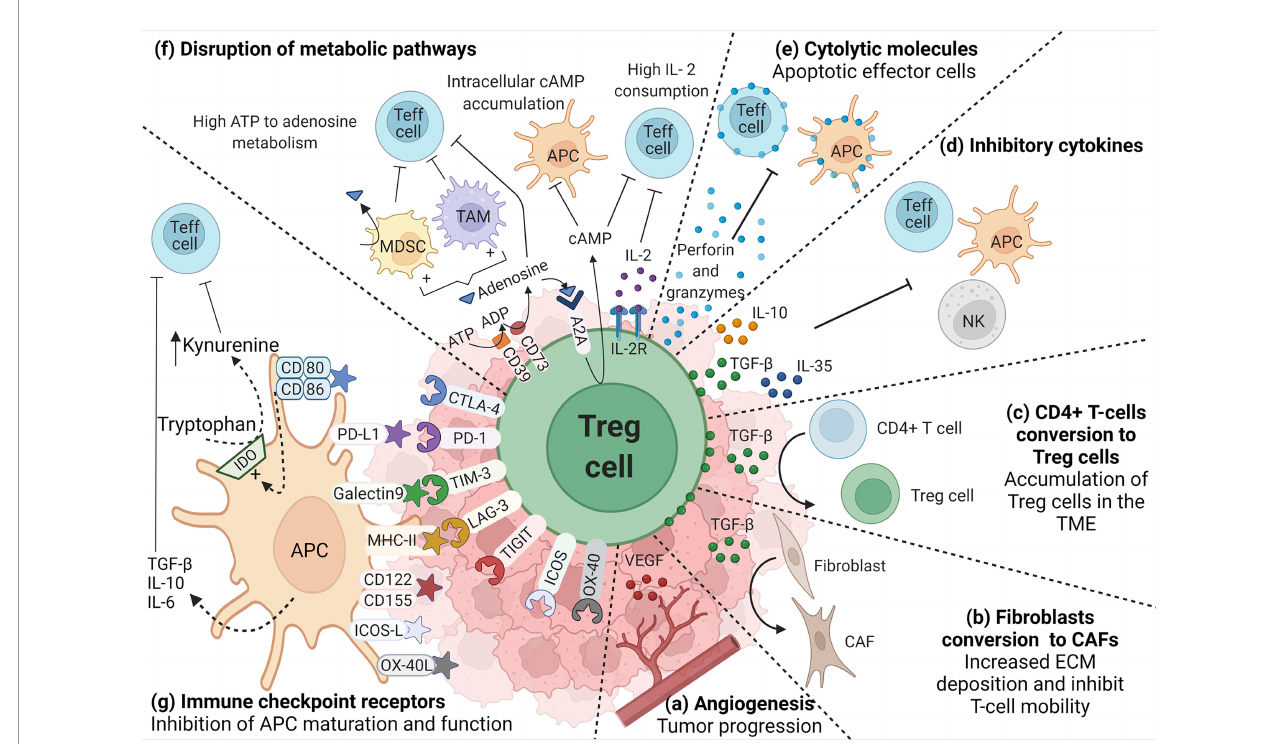
FIGURE 1 | Role of TI-Treg cells in the TME. TI-Treg cells produce (A) VEGF to promote dysregulated angiogenesis associated with tumor progression and TGF- b that, (B) promote the conversion of fi broblast to cancer-associated fi broblasts (CAFs), and (C) the conversion of CD4+ T-cells to Treg cells promoting their accumulation in the TME. TI-Treg cells also regulate anti-tumor immune responses by producing (D) inhibitory cytokines, such as IL-10, TGF- b and IL-35, inhibiting Teff cells, NKs and APCs, the last two are also inhibited through membrane-bound TGF- b , and (E) cytotoxic molecules such as granzymes and perforin that can directly kill Teff cells and APCs. TI-Treg cells also (F) disrupt Teff cell intracellular metabolism impairing their function by depleting IL-2 in the TME. They express CD39 and CD73 ectonucleotidases that covert ATP and ADP into adenosine, which can engage adenosine receptor A2A on the surface of Teff cells, increasing intracellular cAMP and disrupting their metabolism and function. cAMP also binds to APCs and macrophages inducing tolerogenic myeloid-derived suppressor cells (MDSCs) and tumor-associated macrophages (TAMs) that further impact Teff cells. Furthermore, adenosine can also bind A2A in Treg cells promoting the intracellular accumulation of cAMP that can be transferred through gap junctions to Teff cells interfering with their metabolism. Among different molecules that participate in the suppression process, Treg cells highly express (G) immune checkpoint receptors that bind their corresponding ligand in APCs and differently regulate their function (increasing the release of inhibitory cytokines or the upregulation of IDO) promoting an immunosuppressive